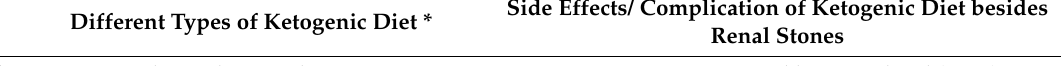
Table 1. Side effects observed in ketogenic diets in different trials (table adapted from Acharya et al. 2021 with permission from author